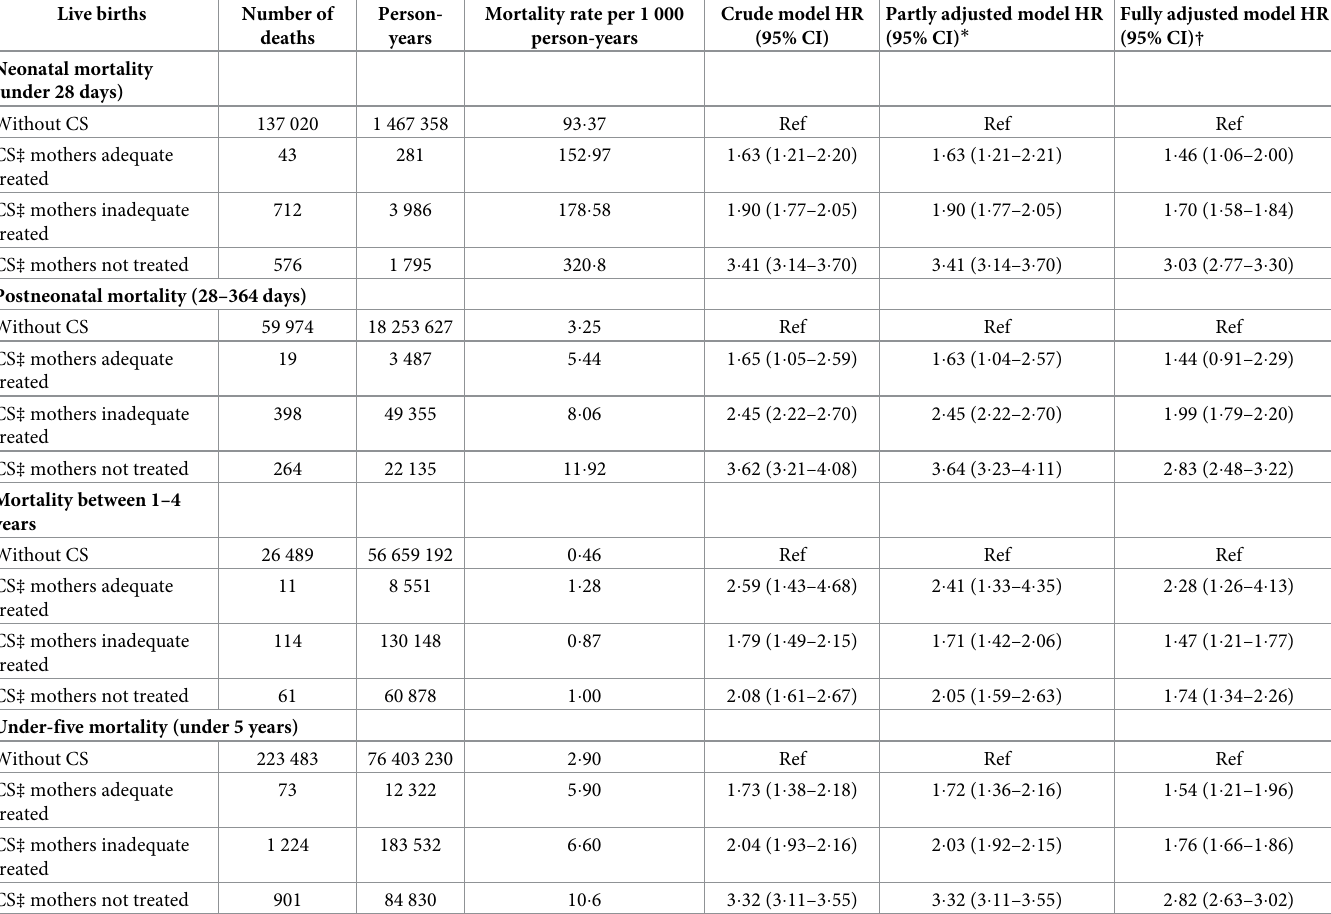
Table 3. Mortality risk by age group and maternal treatment status among singleton live births in the cohort-linked data, Brazil,